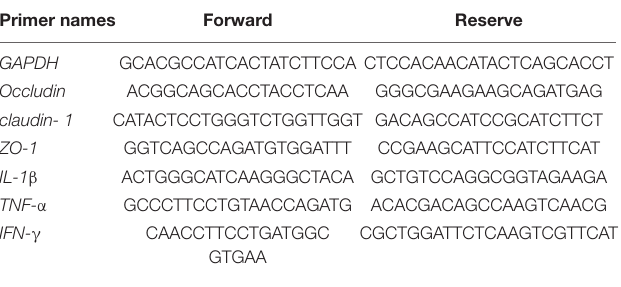
TABLE 1 | Sequences for real-time PCR